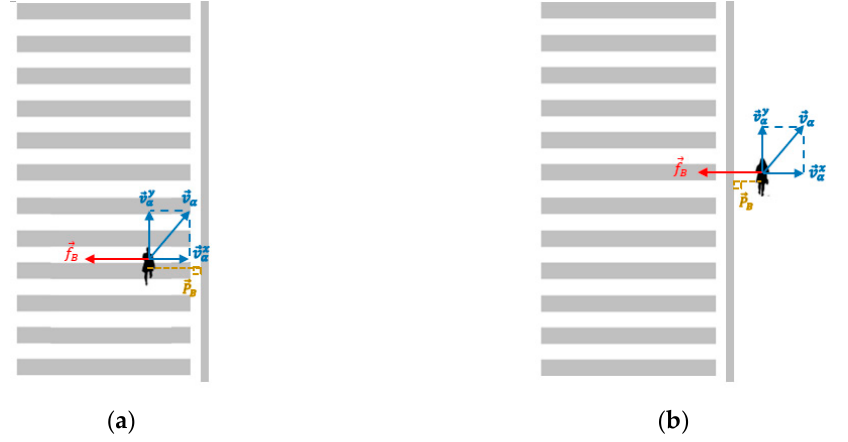
Figure 4. Repulsive and attractive forces at the crosswalk boundary. ( a ) Repulsive boundary force; ( b ) attractive boundary force.